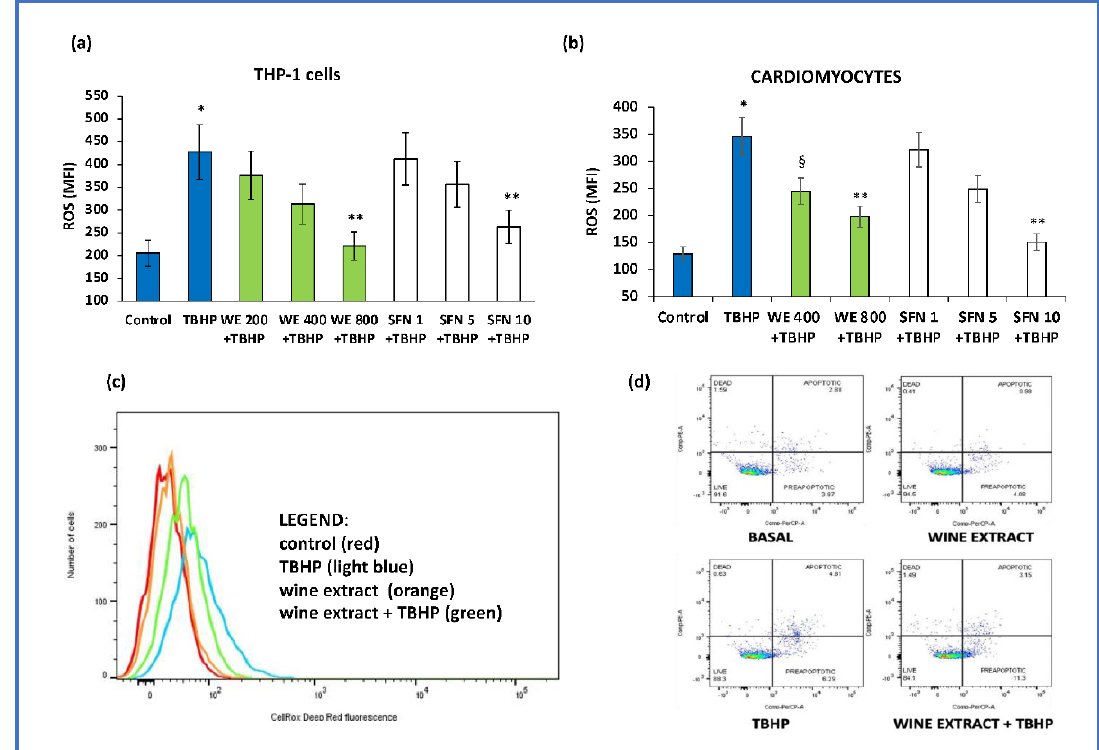
Figure 4. Dose – response effect of wine extract (WE) and sulforaphane (SFN) on oxidative stress- induced intracellular reactive oxygen species (ROS) formation. ( a , b ) THP-1 cells and cardiomyocytes were pre-incubated with increasing concentrations (from 200 to 800 μ g/mL of total polyphenols) of WE and SFN (1 – 10 μ M) before the addition of tert-butyl hydroperoxide (TBHP, 100 μ M). Data represent the mean +/ − standard deviation of measurements performed in triplicate in three different experiments; * p < 0.01 increase vs. control; ** p < 0.001 decrease vs. THBP; § p < 0.1 decrease vs. TBHP. ( c ) Representative flow cytometry analysis of ROS generation induced by TBHP and the inhibitory effect of the highest dose of wine extract. ( d ) Representative flow cytometry analysis on cell viability of the highest dose of wine extract.